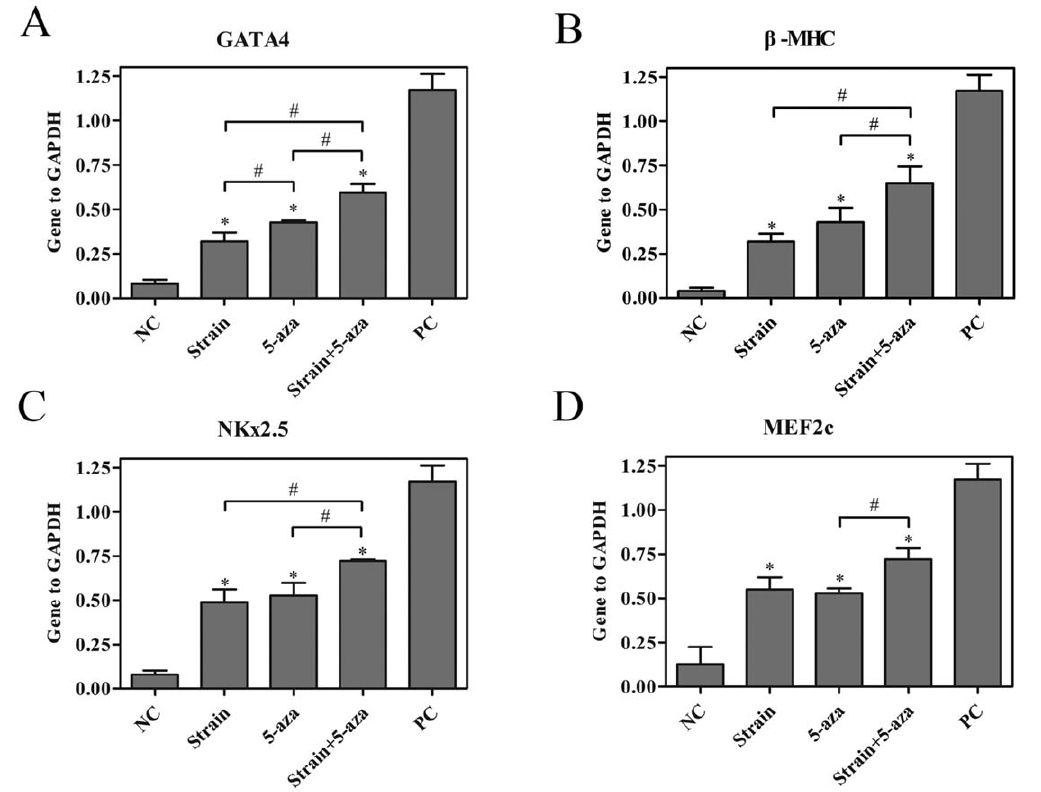
Figure 7. Effects of biochemical and physical stimuli on the cardiac-related gene expressions of rBMSCs. rBMSCs were cultured under static conditions, or exposed to cyclic strain of 10% at a frequency of 1 Hz, or given 10 m M 5-aza, or treated with cyclic strain of 10% at a frequency of 1 Hz combined with 10 m M 5-aza for 24 h. mRNA expression levels of GATA-4, b -MHC, NKx2.5 and MEF2c were assessed on the 7 th day by quantitative real-time RT-PCR analysis. The expression of each gene was normalized based on the expression of GAPDH. (A) GATA4. (B) b -MHC. (C) NKx2.5. (D) MEF2c. NC, negative control (rBMSCs treated with regular complete medium); PC, positive control (normal neonatal rat cardiomyocytes). Results are shown as the mean 6 SD values (n=3). * P , 0.05 compared to the NC group; # P , 0.05.